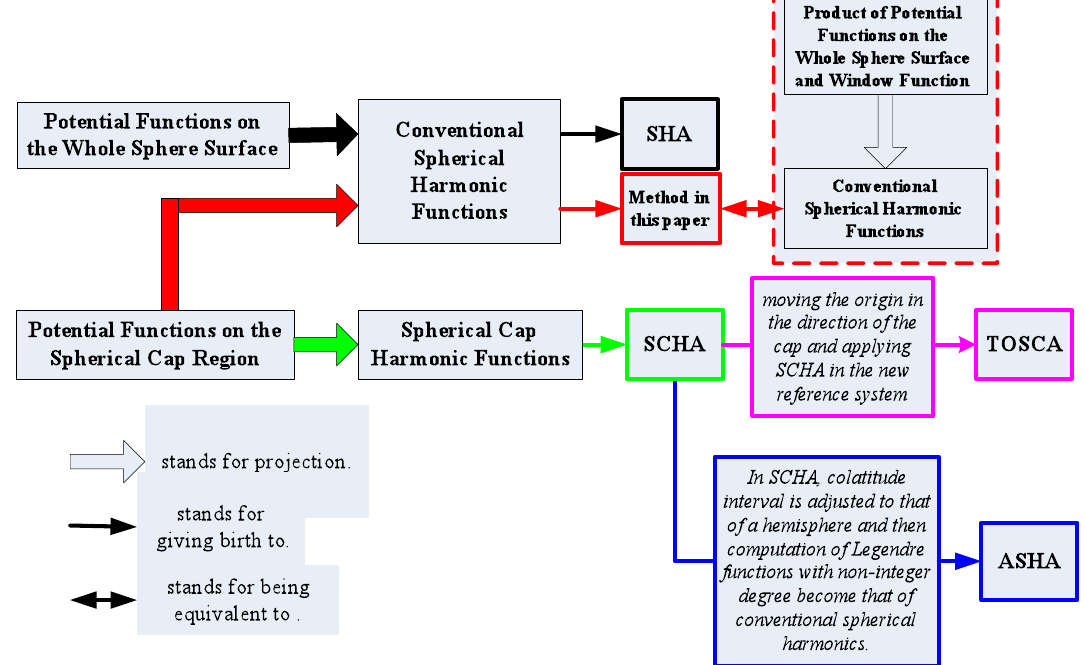
Figure 3. The relationships between SHA, SCHA, TOSCA, ASHA and the method in the present study.